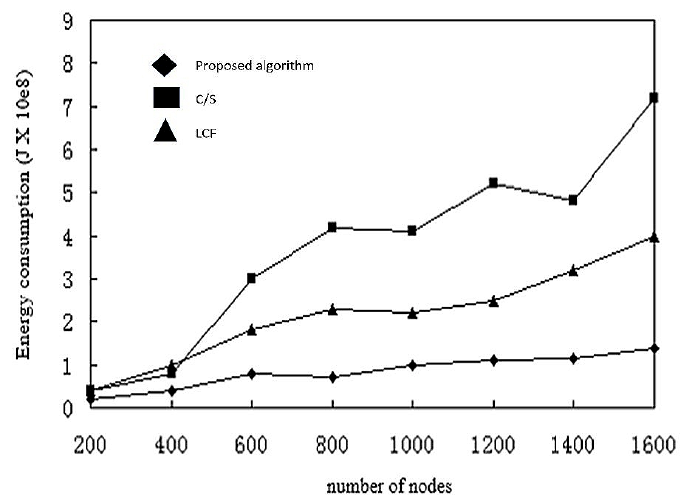
Figure 19. Delay for different target numbers.